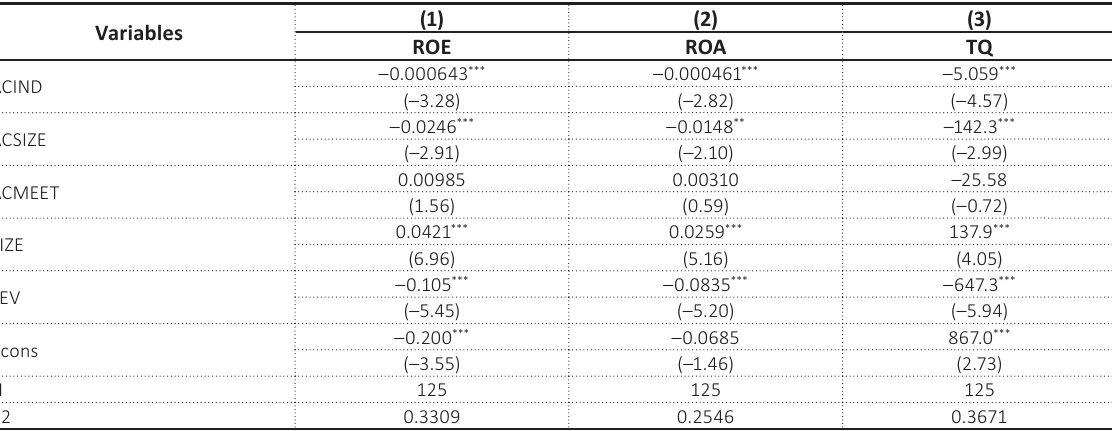
Table 5. Regression results in terms of different